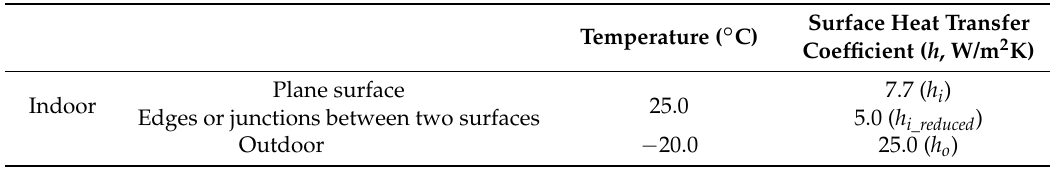
Table 4. Boundary conditions for TDR simulations.